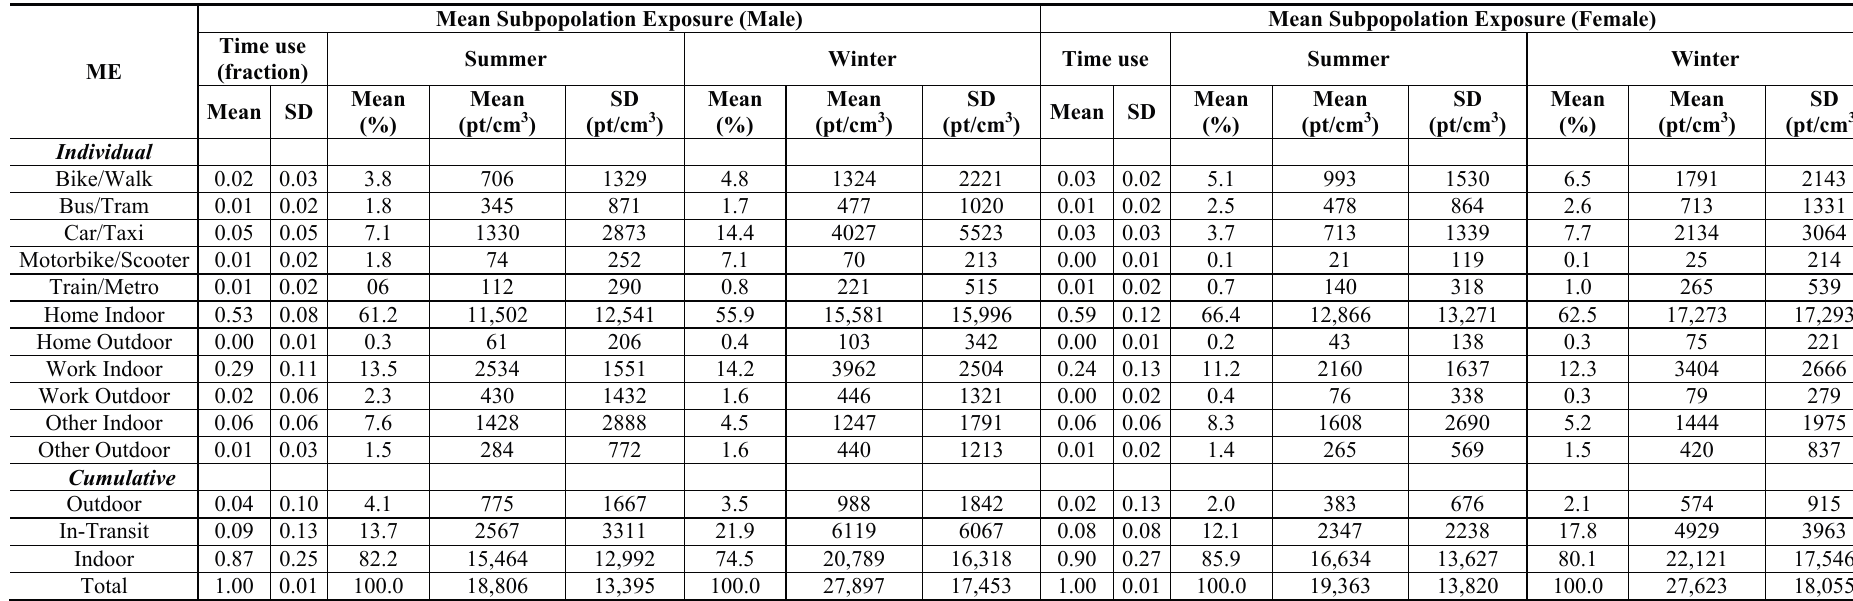
Table 4. Summary of the mean simulated exposures segregated for each ME and season. Results are shown for the mean male and female profiles among all